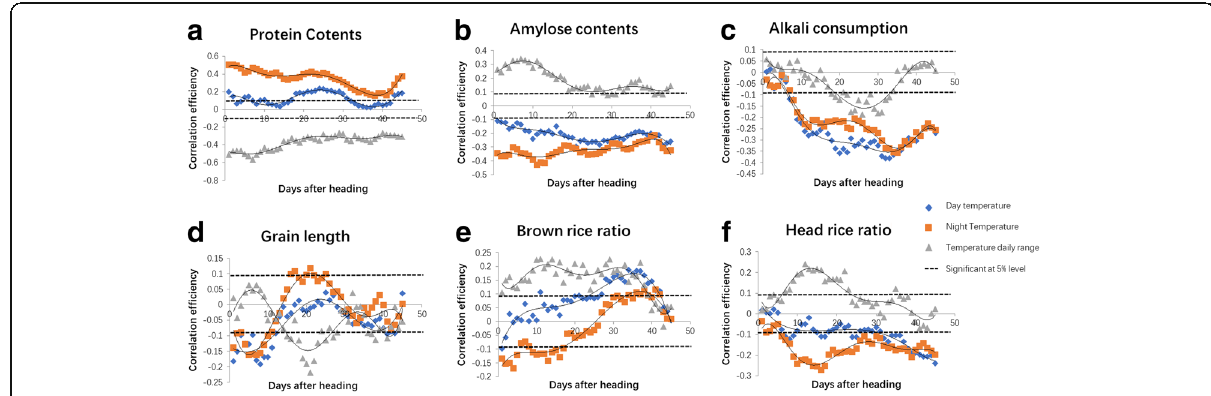
Fig. 4 The dynamic analysis of the correlation of temperature factors to quality traits. The correlation efficiency of temperature factors (day average temperature, night average temperature, and daily temperature range) to a protein content, b amylose content, c alkali consumption, d grain length, e brown rice ratio, and f head rice